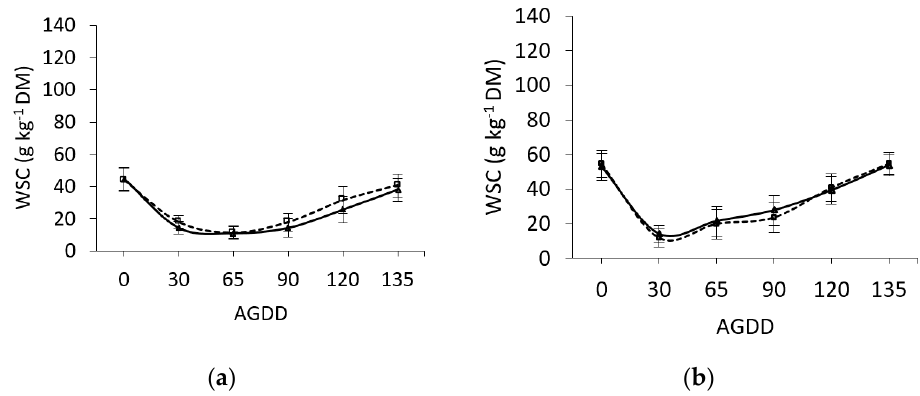
Figure 2. Mean of two growth cycles for water-soluble carbohydrate (WSC) concentration (g kg − 1 dry matter (DM)) in leaf blades ( a ) and leaf sheaths ( b ) for L. perenne (-- □ --) and B. valdivianus Phil. (- △ -) plots defoliated at 135 accumulated growing degree days (AGDDs). Bars indicate standard error.